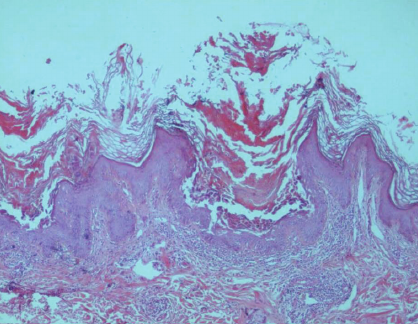
Figure 1: Epidermis with acanthosis premature keratosis and suprabasal acantholysis. A group of dyskeratotic cells (corps ronds and grains) is seen in the bottom of the suprabasal cleft (100x, H&E).